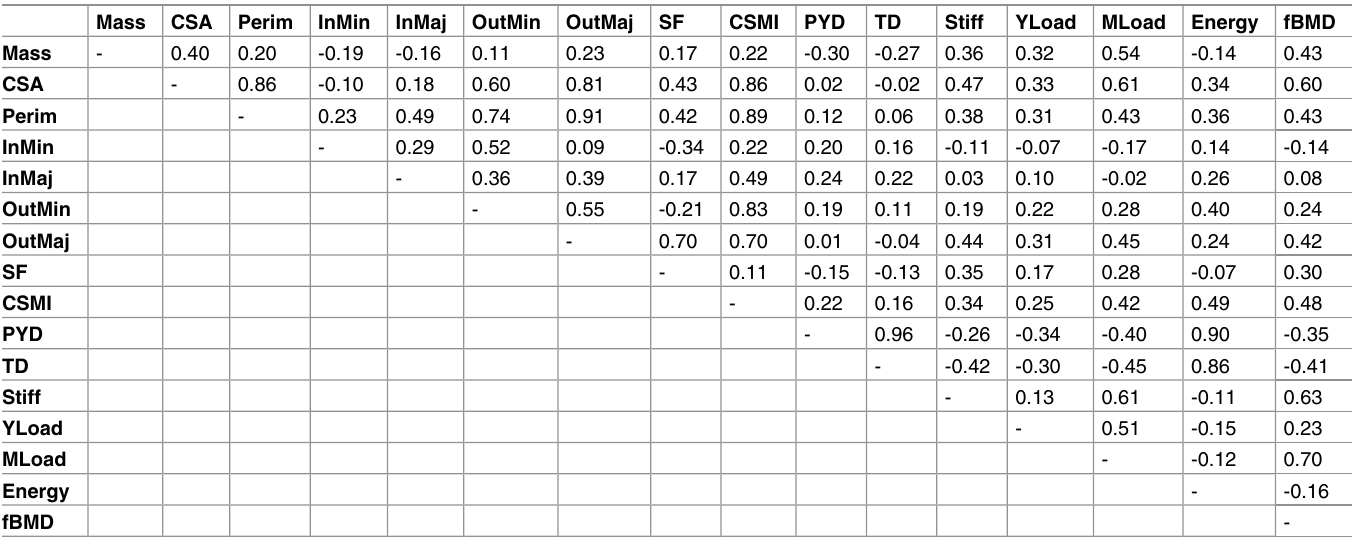
Table 5. Correlations among phenotypes.